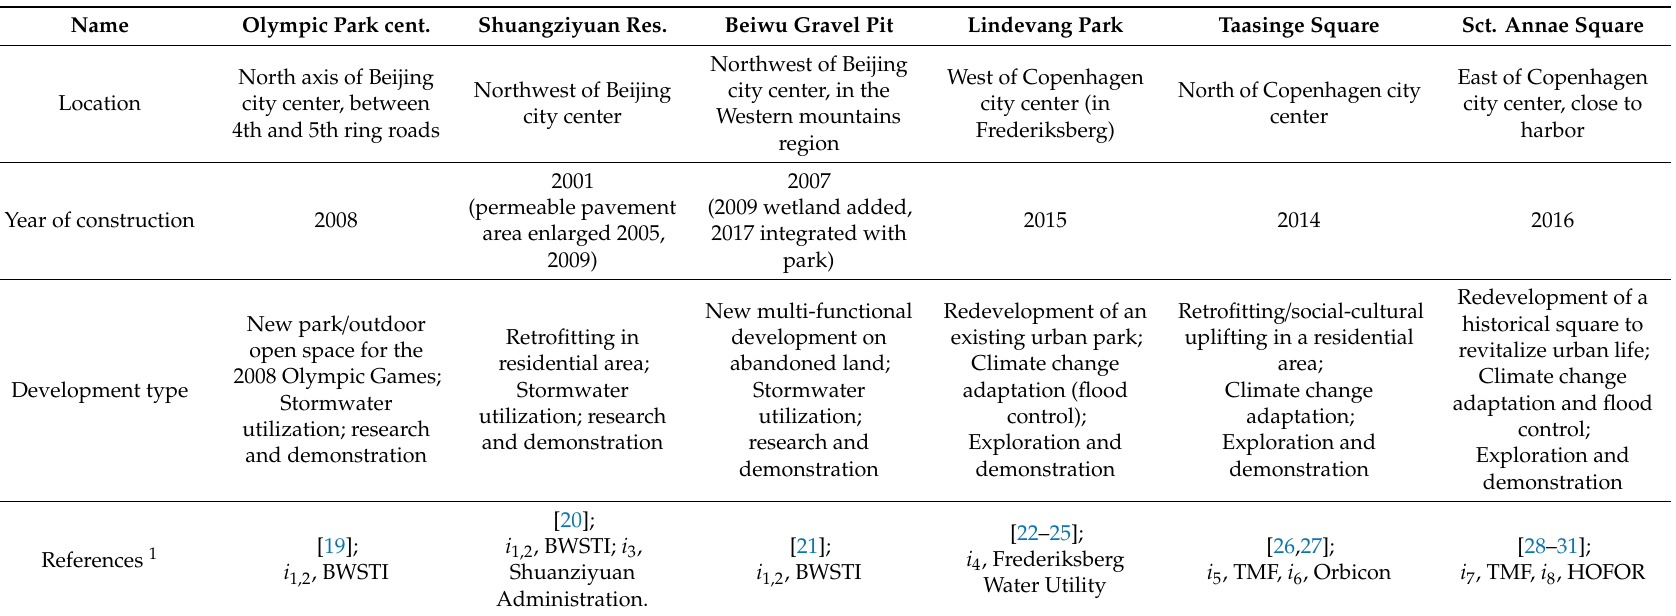
Table 2. Facts of the six municipality-led pilot projects in Beijing and